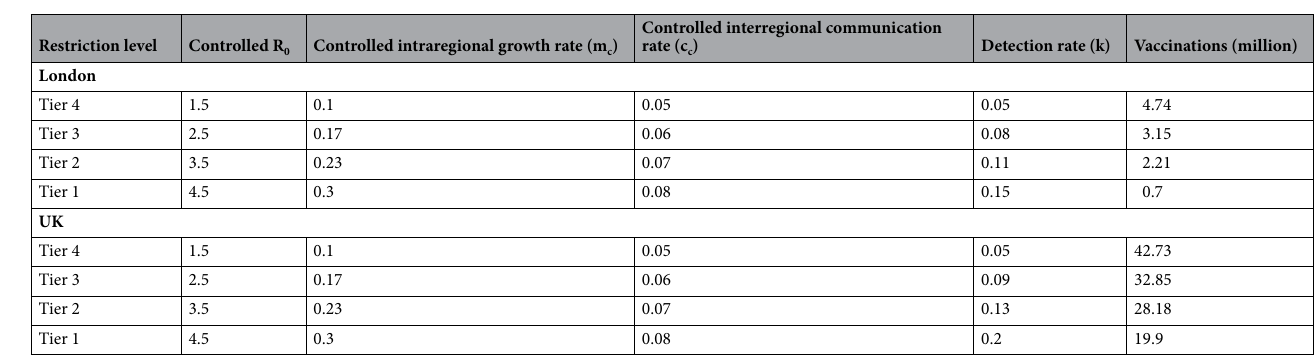
Table 2. The detection number and vaccination demand under different intervention